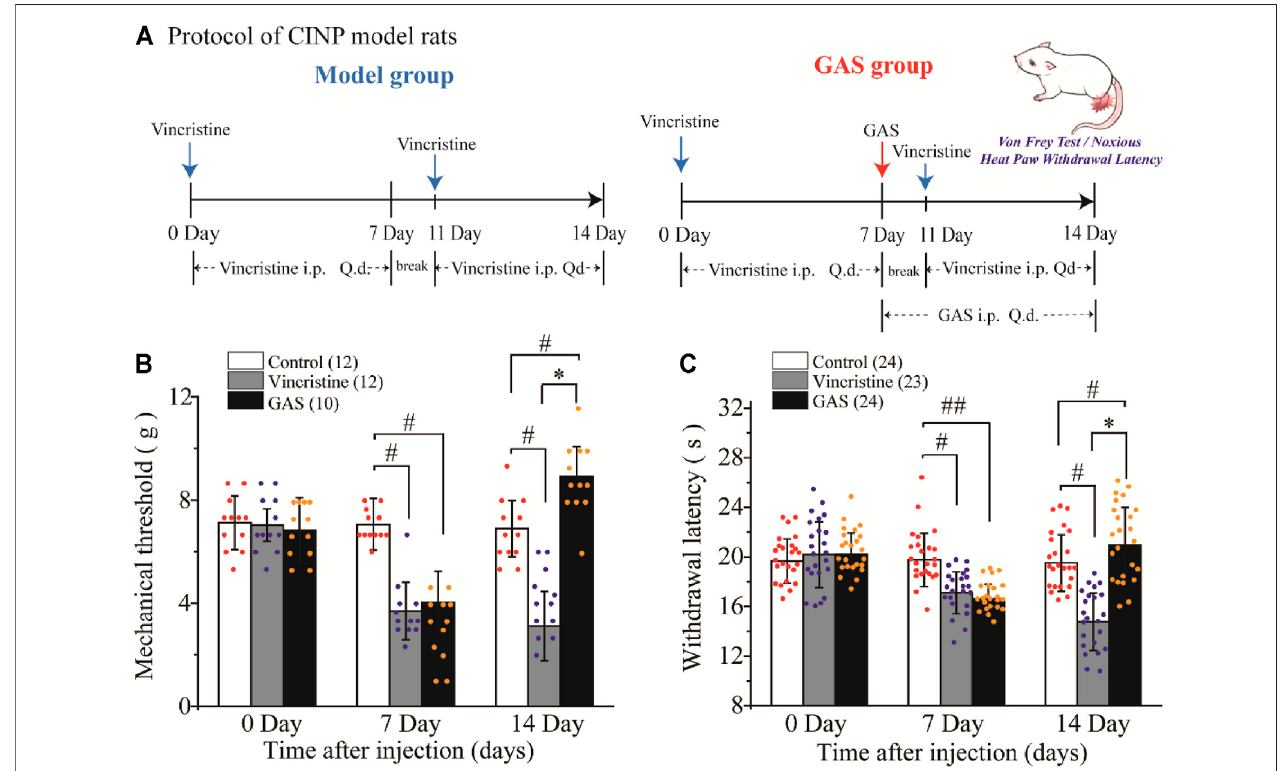
FIGURE 1 | The effects of GAS on alleviating the symptoms of vincristine-induced CINP rats: (A) Administration protocol of GAS in the treatment of neuropathic pain model rats caused by vincristine; (B) The effects of GAS against vincristine-induced hyperalgesia on mechanical paw withdrawal duration in a pinprick test, and the mechanical paw withdrawal threshold was measured at 0, 7, 14 Day; (C) Effects of GAS on plantar thermal pain in vincristine model rats, and the thresholds were measured at 0, 7, 14 Day ( #p < 0.05, ##p < 0.01, compared to the control group; *p < 0.05, compared to the model group; ANVOA- Bonferroni Test ).